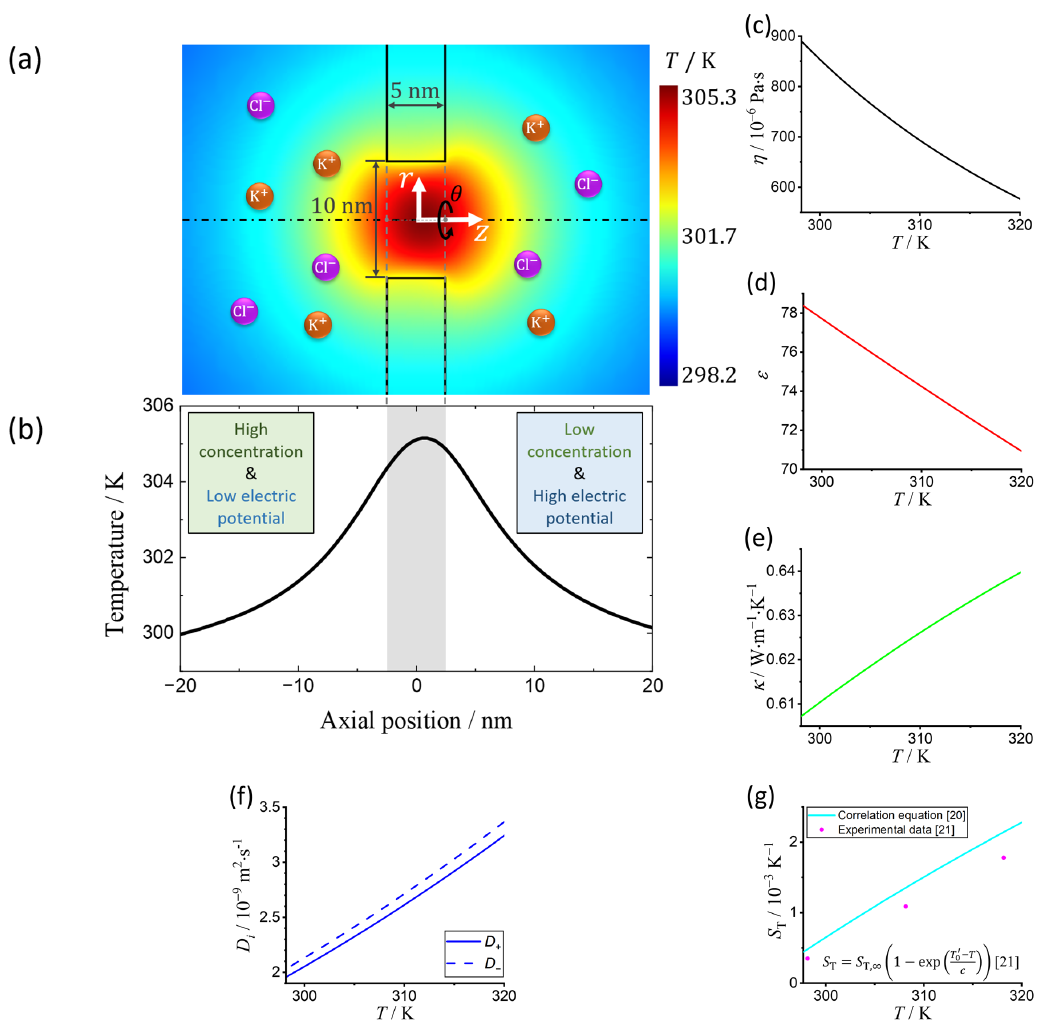
Figure 1. ( a ) Schematic illustration of a 10 nm (in diameter) nanopore separating two KCl solutions 1 with di ff erent concentrations. The concentration of the solution on the left side of the reservoir is higher than that on the right side, whereas the electric potential on the right side is higher than that on the left side. The temperature inside the nanopore has a significant increase due to Joule heating e ff ects. ( b ) Typical axial temperature distribution in an ultrathin nanopore with Joule heating e ff ects. (The shaded part indicates the position of the nanopore.) Relations between the ( c ) viscosity η of pure water, ( d ) static dielectric constant ε , and ( e ) thermal conductivity κ and temperature T at 0.1 MPa. Temperature responses of the ( f ) di ff usivity D i , and ( g ) Soret coe ffi cient S T of aqueous KCl, where the − subscript i of “ + , − ” denotes the cation K + and anion Cl ,